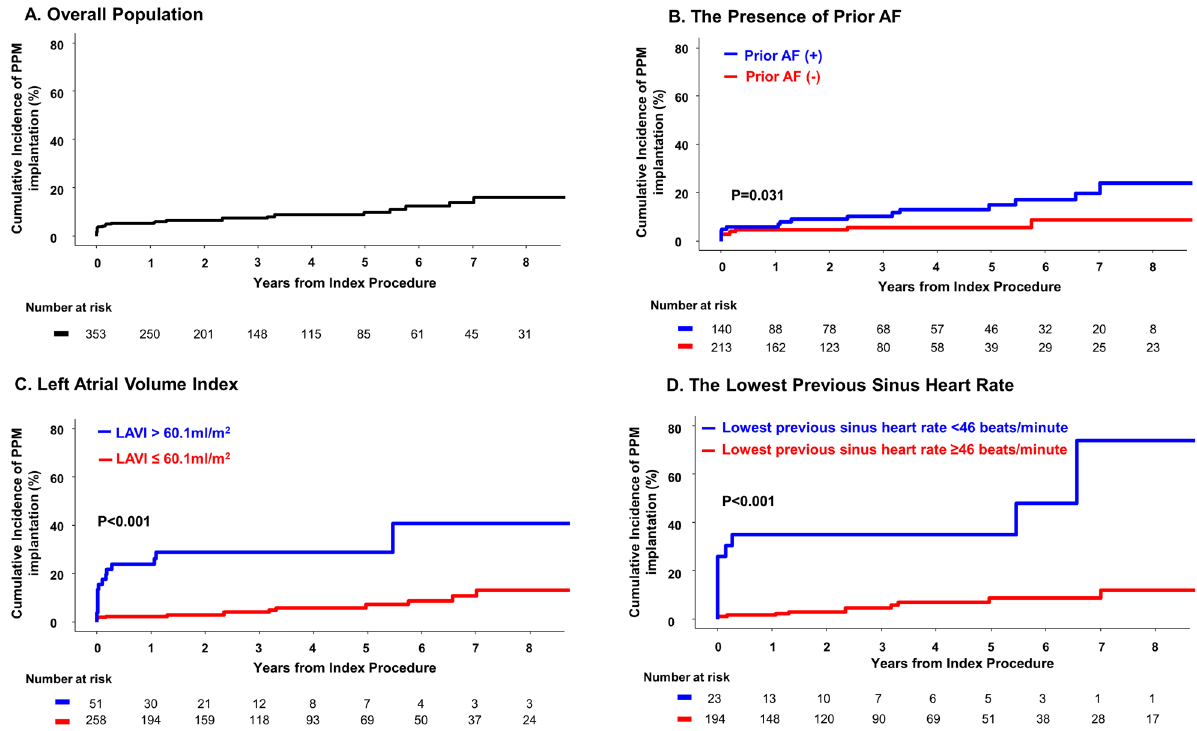
Figure 3. Kaplan–Meier Estimates of the Incidence of PPM Implantation after CTI-dependent AFL ablation. ( A ) Kaplan–Meier curves for PPM implantation after AFL ablation in overall population. ( B ) Kaplan–Meier curves for PPM implantation after AFL ablation according to the presence of prior AF. ( C ) Kaplan–Meier curves for PPM implantation after AFL ablation according to LAVI (cut-off value: 60.1 ml/m 2 ). ( D ) Kaplan–Meier curves for PPM implantation after AFL ablation according to the lowest previous sinus heart rate (cut-off value: 46 beats per minute). AF atrial fibrillation, AFL atrial flutter, CTI cavotricuspid isthmus, LAVI left atrial volume index, PPM permanent